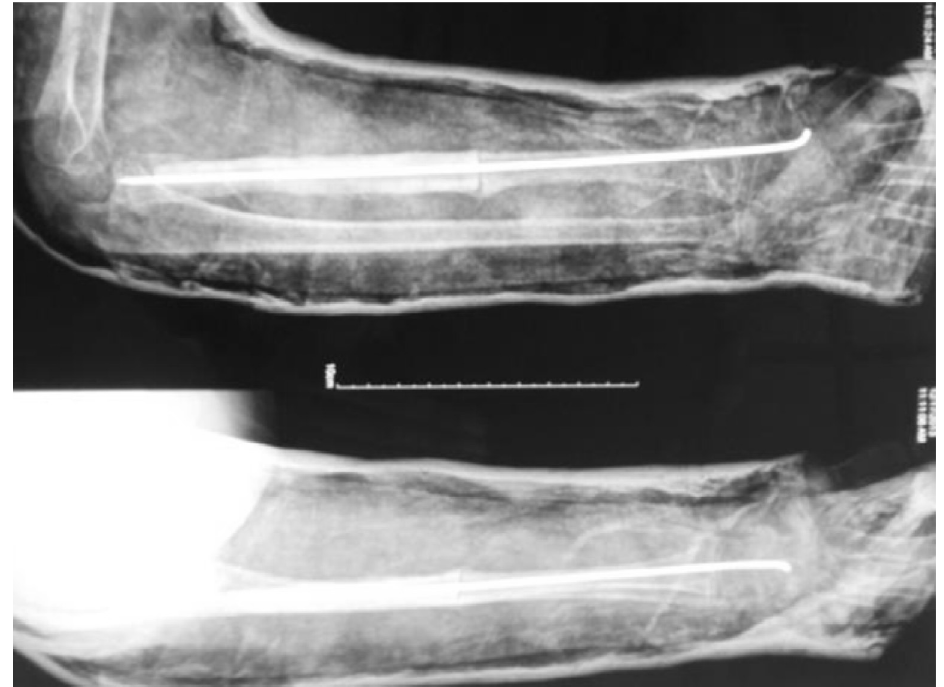
Figure 6. Postoperative X-ray showing reconstruction of the radius using maternal fibular graft fixed with an intramedullary K-wire.